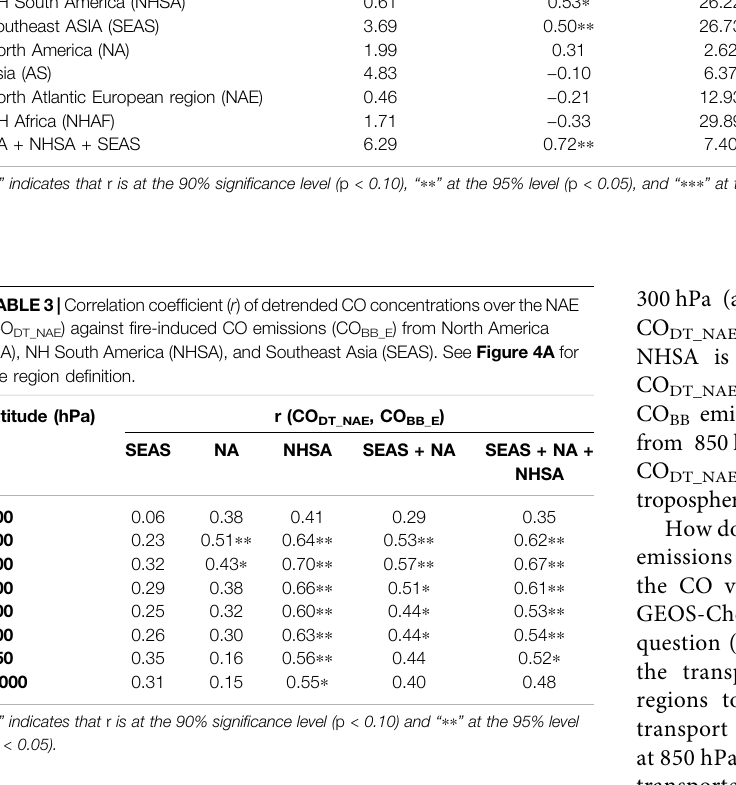
TABLE 2 | CO emissions from biomass burning (CO BB_E ) in different regions based on GFED4.1s data. Correlation coef fi cients ( r ) between the ENSO index and CO BB_E , air temperature (T), and precipitation (Precip) at the surface. See Figure 4A for the region de fi nition. Source region